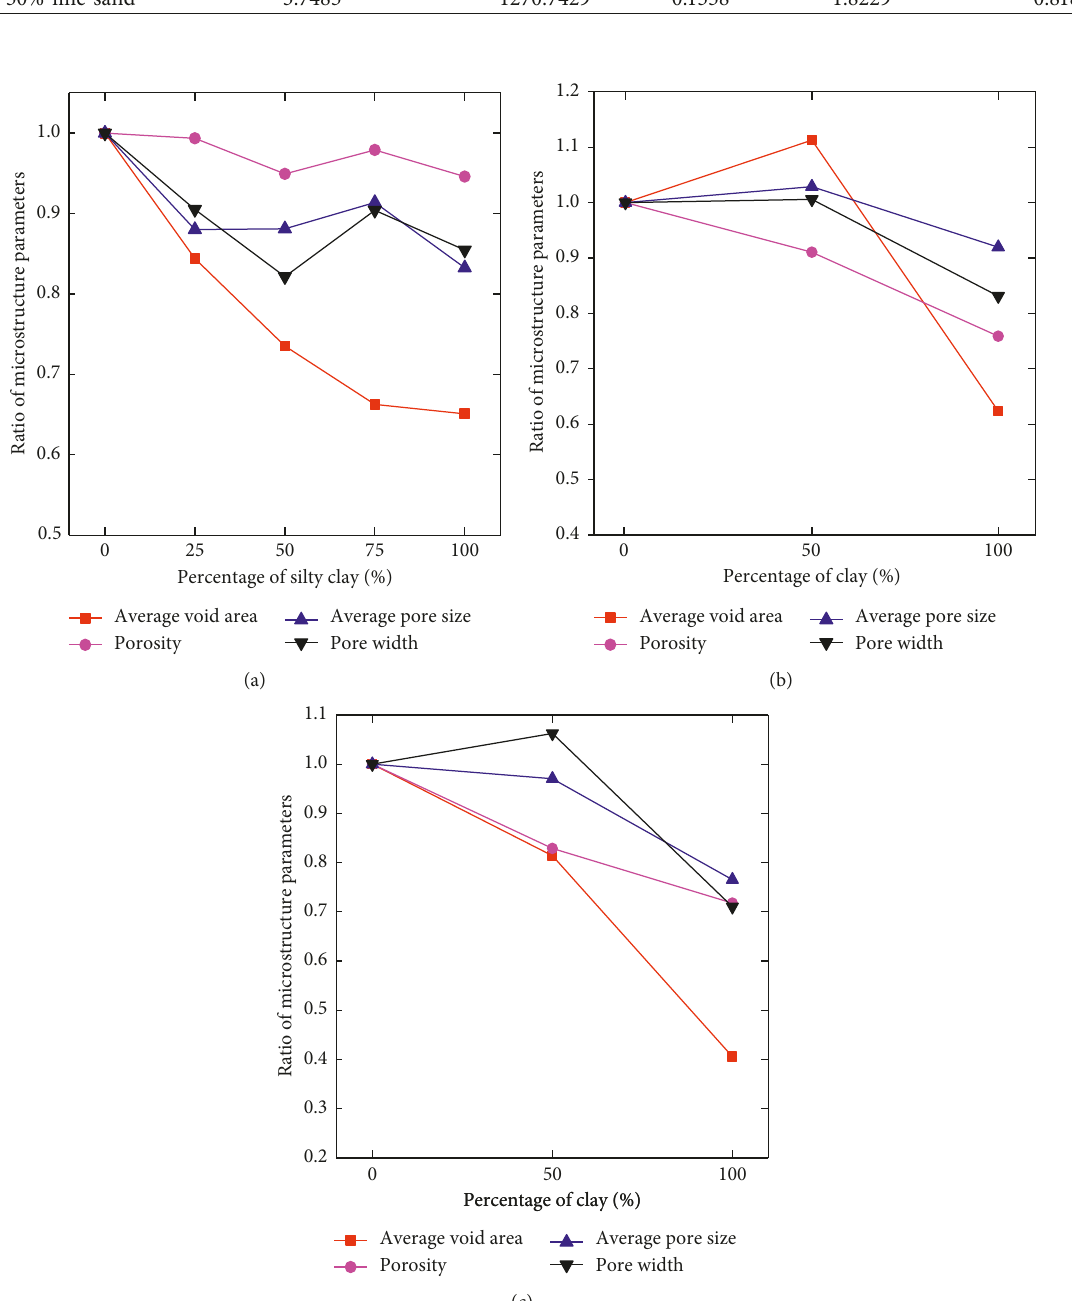
Figure 10: Comparison of mixed-soil cement microstructure parameters: (a) fine sand+ silty clay; (b) clay +silty clay; (c) clay +fine